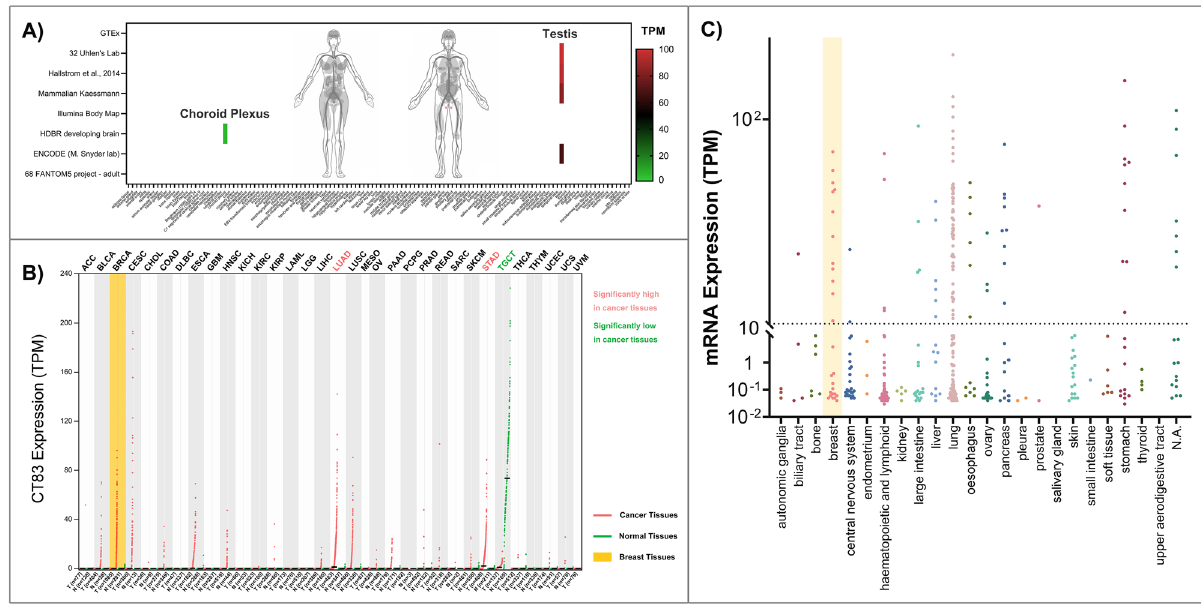
Figure 3. The expression of CT83 in normal tissues, cancer tissues, and cancer cell lines. ( A ) The expression of CT83 in normal adult tissues based on 8 RNA-seq datasets obtained from the Expression Atlas. ( B ) The expression of CT83 in pan-cancer and paired normal tissues based on RNA-seq data from the GEPIA2 database. The abbreviations of involved cancers are available on this webpage (https:// gdc. cancer. gov/ resou rces- tcga- users/ tcga- code- tables/ tcga- study- abbre viati ons). ( C ) The expression of CT83 in pan-cancer cell lines based on RNA-seq data from the CCLE